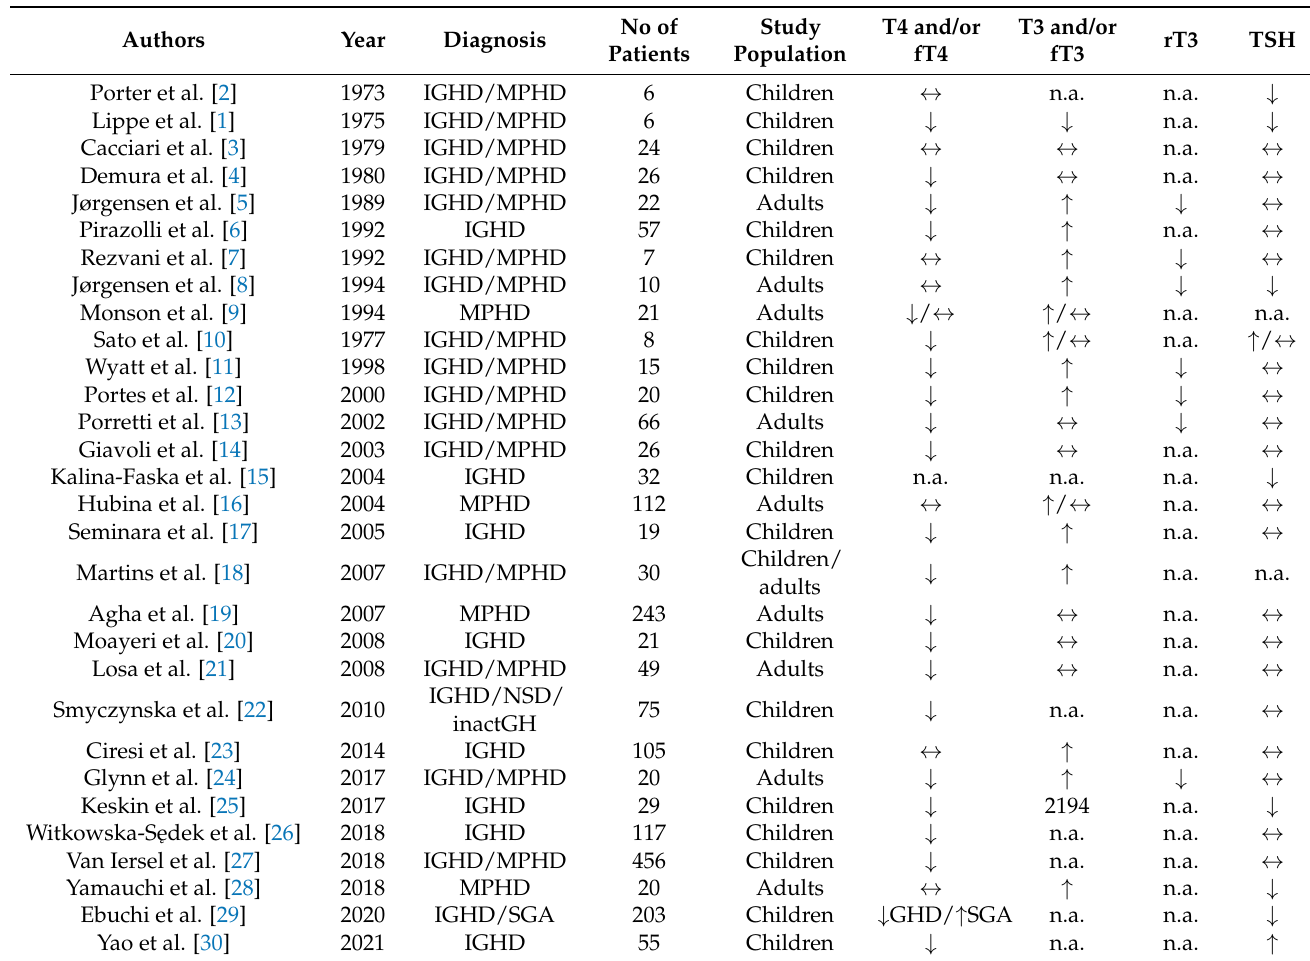
Table 1. Characteristics of the studies evaluating effects of rhGH therapy on thyroid function in GHD